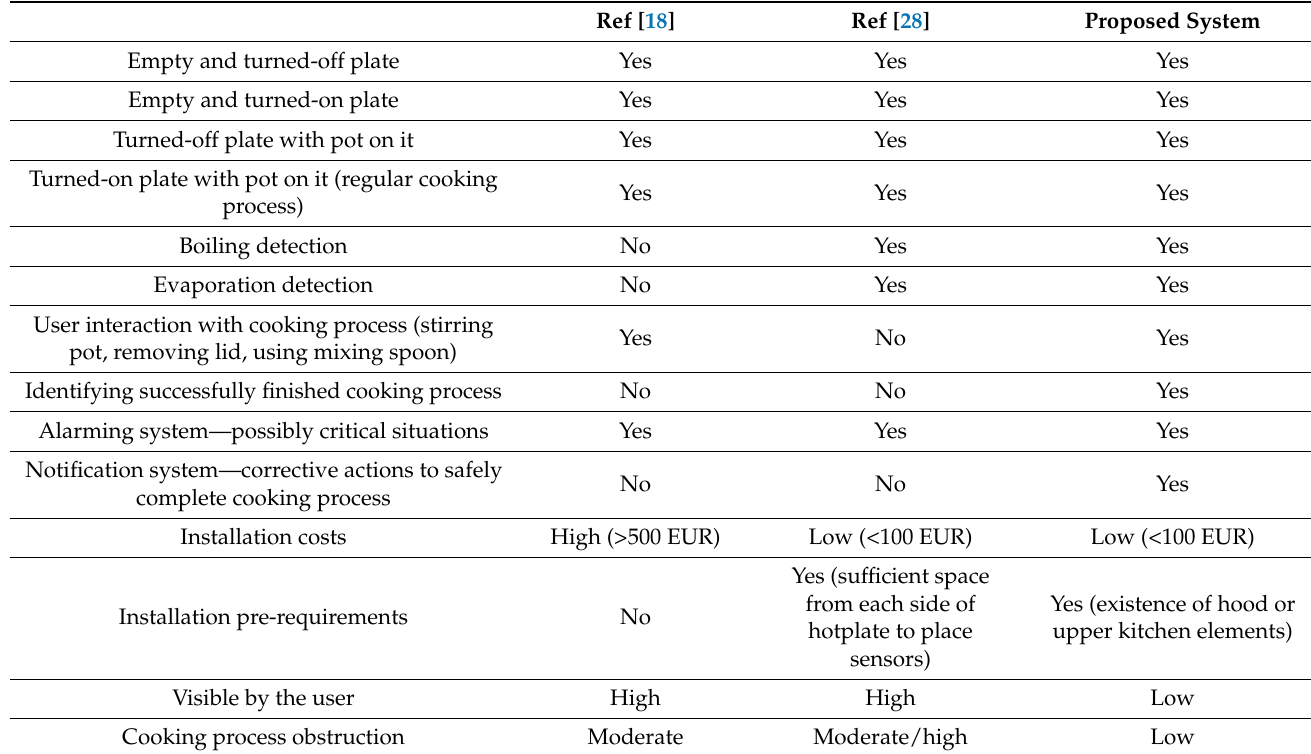
Table 9. Comparison with other